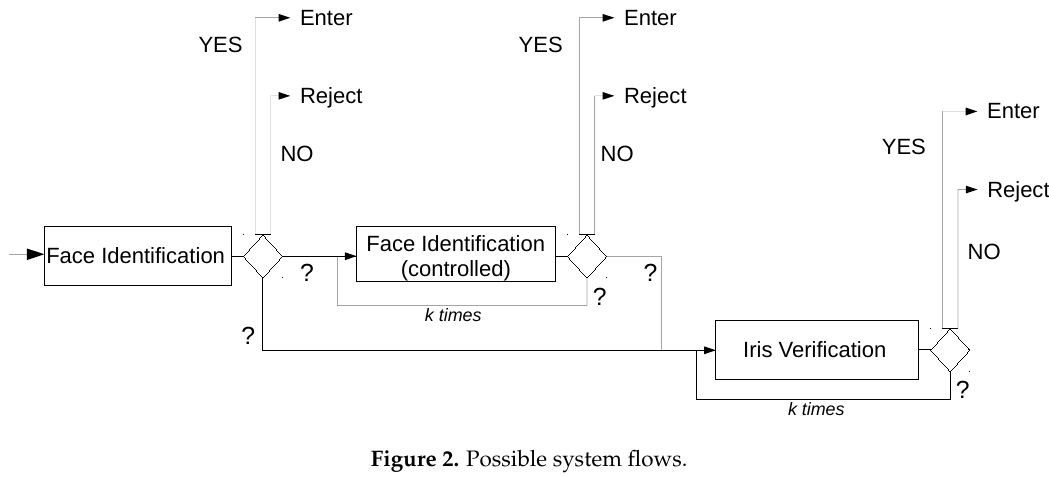
Figure 2. Possible system